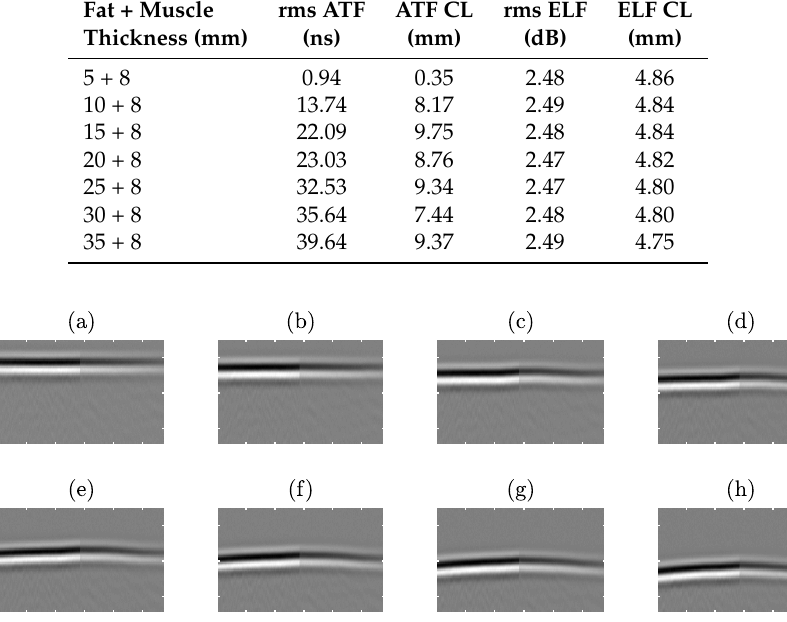
Figure 9. Simulated received wavefronts by the effective aperture after geometric compensation. Wavefronts are shown on a linear grey scale with time as the vertical axis and element number as the horizontal axis. The temporal range shown is 2.92 ms for 288 elements. Cases with different thicknesses of fat layer are shown: ( a ) 0 mm (control case); ( b ) 5 mm; ( c ) 10 mm; ( d ) 15 mm; ( e ) 20 mm; ( f ) 25 mm; ( g ) 30 mm; ( h ) 35